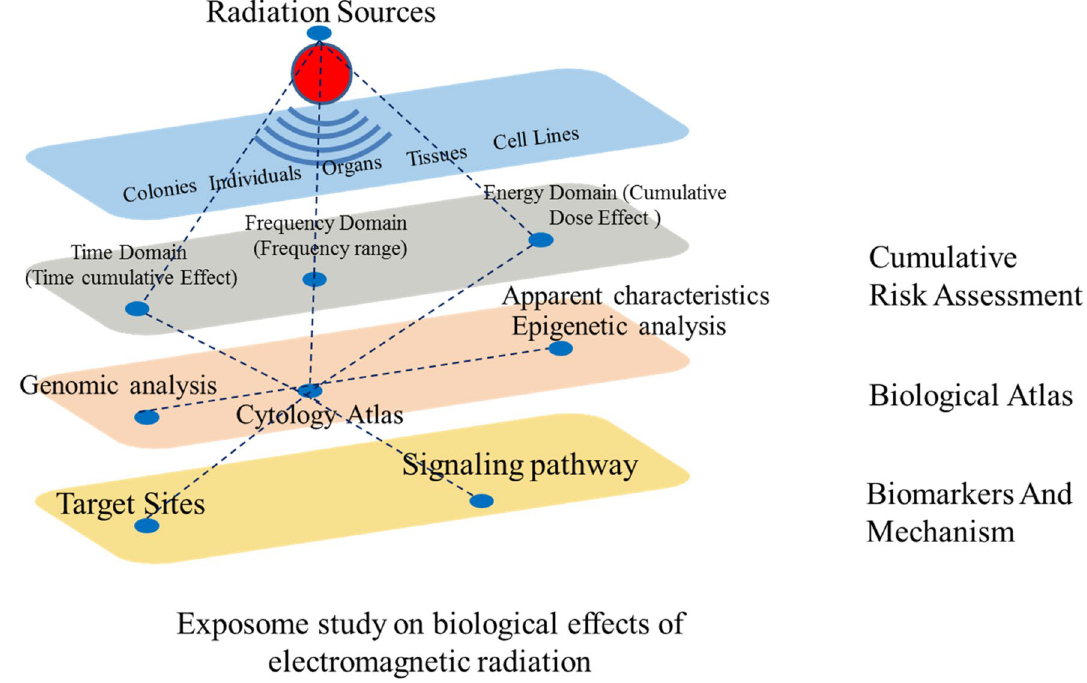
Figure 3. Future research